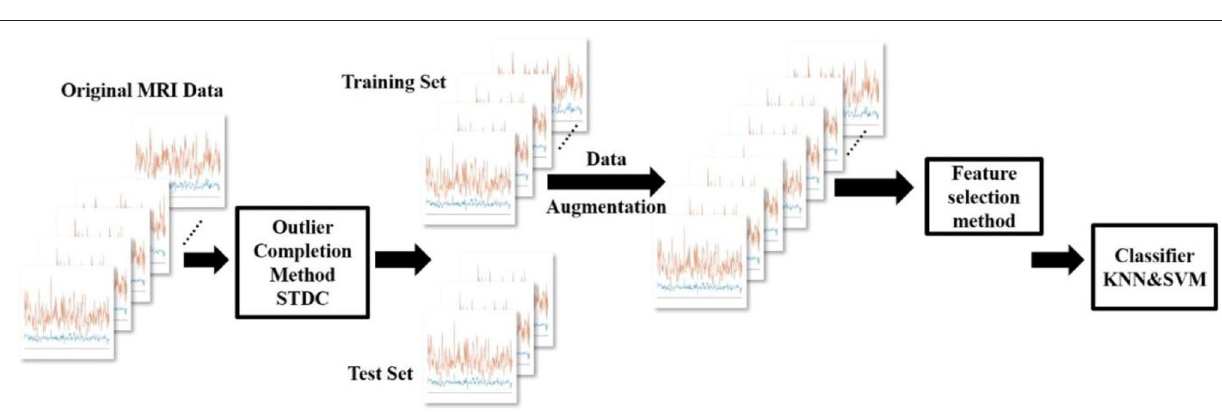
(Adam) optimizer, with learning rate lr = 0.001, β 1 = 0.9, and β 2 = 0.999. The network is trained using 300 epochs, and